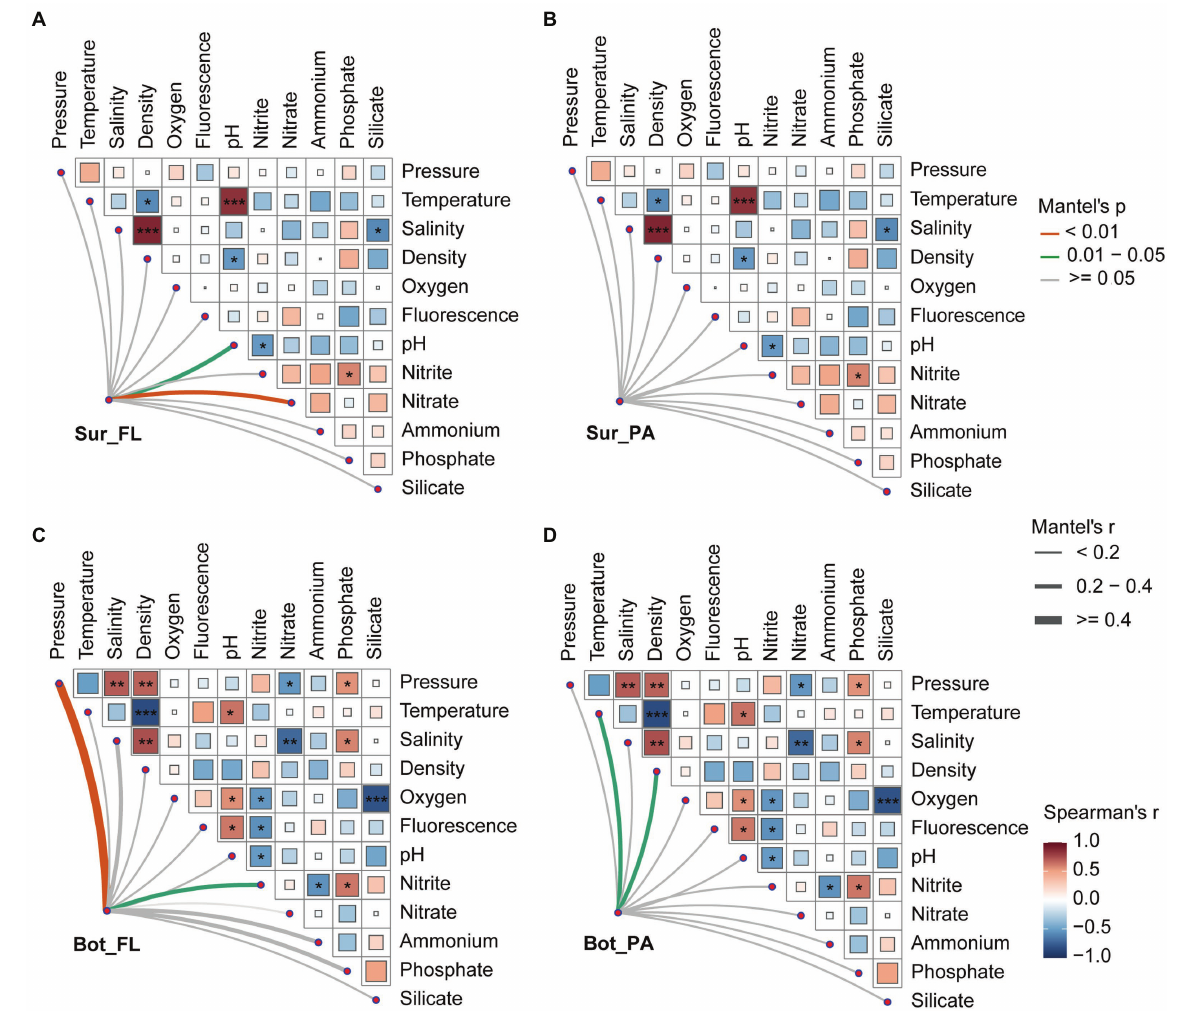
FIGURE 6 Relationships between microbial community and environmental factors in surface and bottom waters. (A) Sur_FL community; (B) Sur_PA community; (C) Bot_FL community; (D) Bot_PA community. Pairwise comparisons of environmental factors are shown, with a color gradient denoting Spearman’s correlation